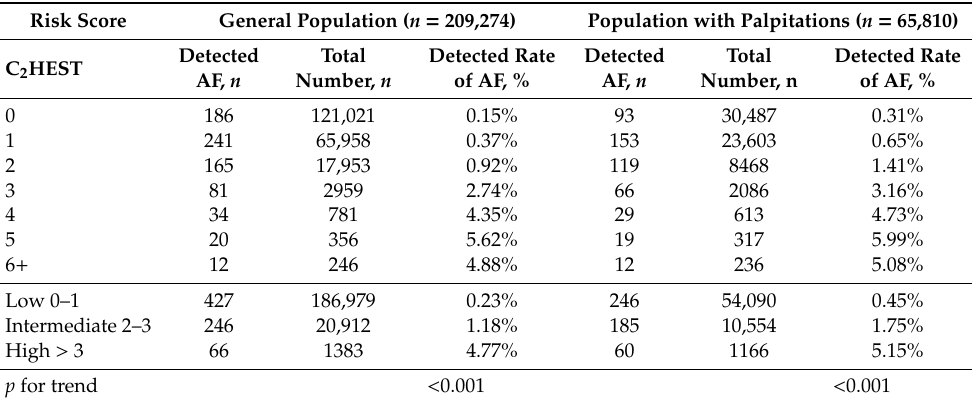
Table 3. Detected AF, in relation to C 2 HEST distribution, in the general population and those with